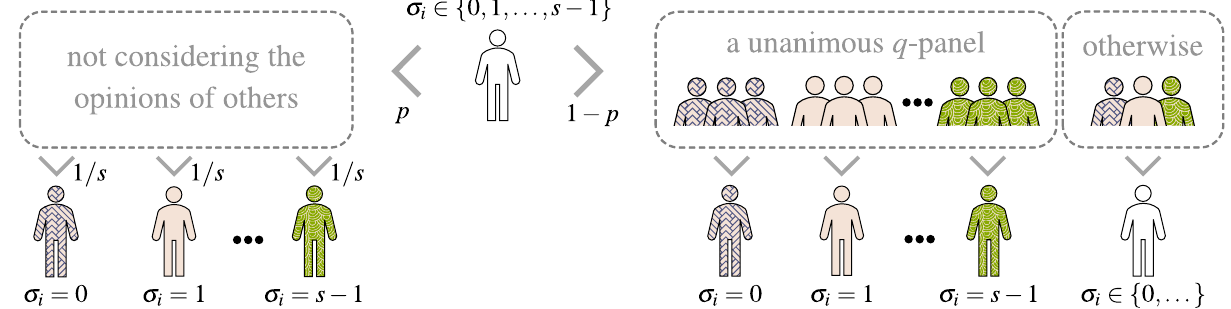
Figure 1. Visualization of an elementary update for the multi-state q -voter model with independence. Within the annealed approach two alternative social responses, independence and conformity, appear with complementary probabilities p and 1 − p . Whereas, within the quenched approach, a fraction p of agents is permanently independent, whereas others are always